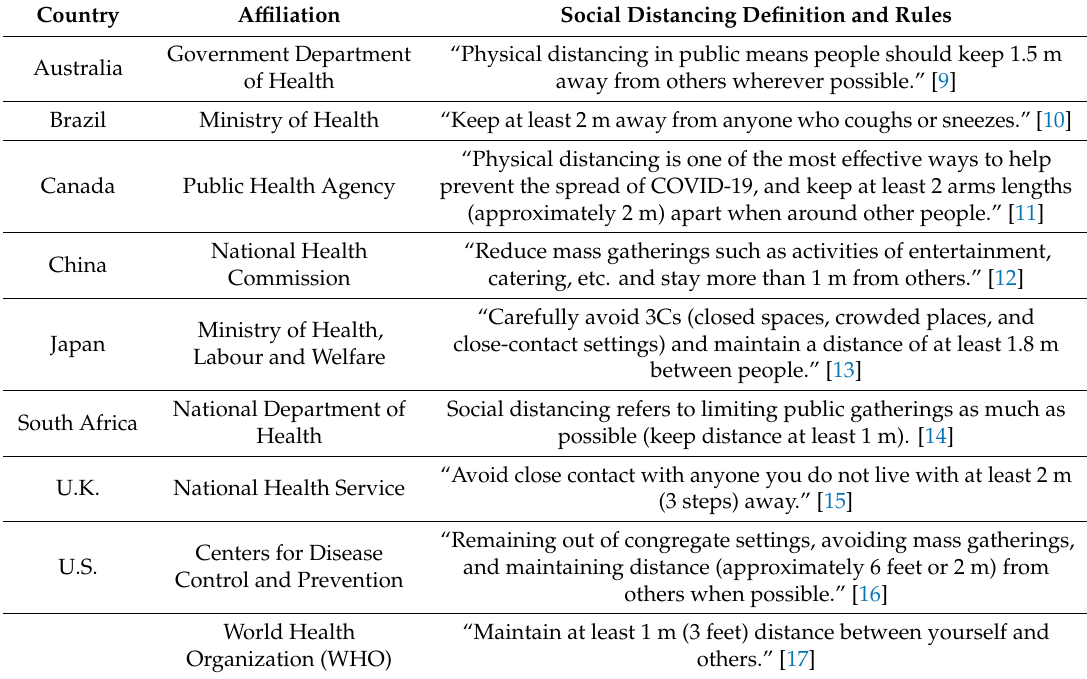
Table 1. Social distancing definitions and rules by country and a ffi